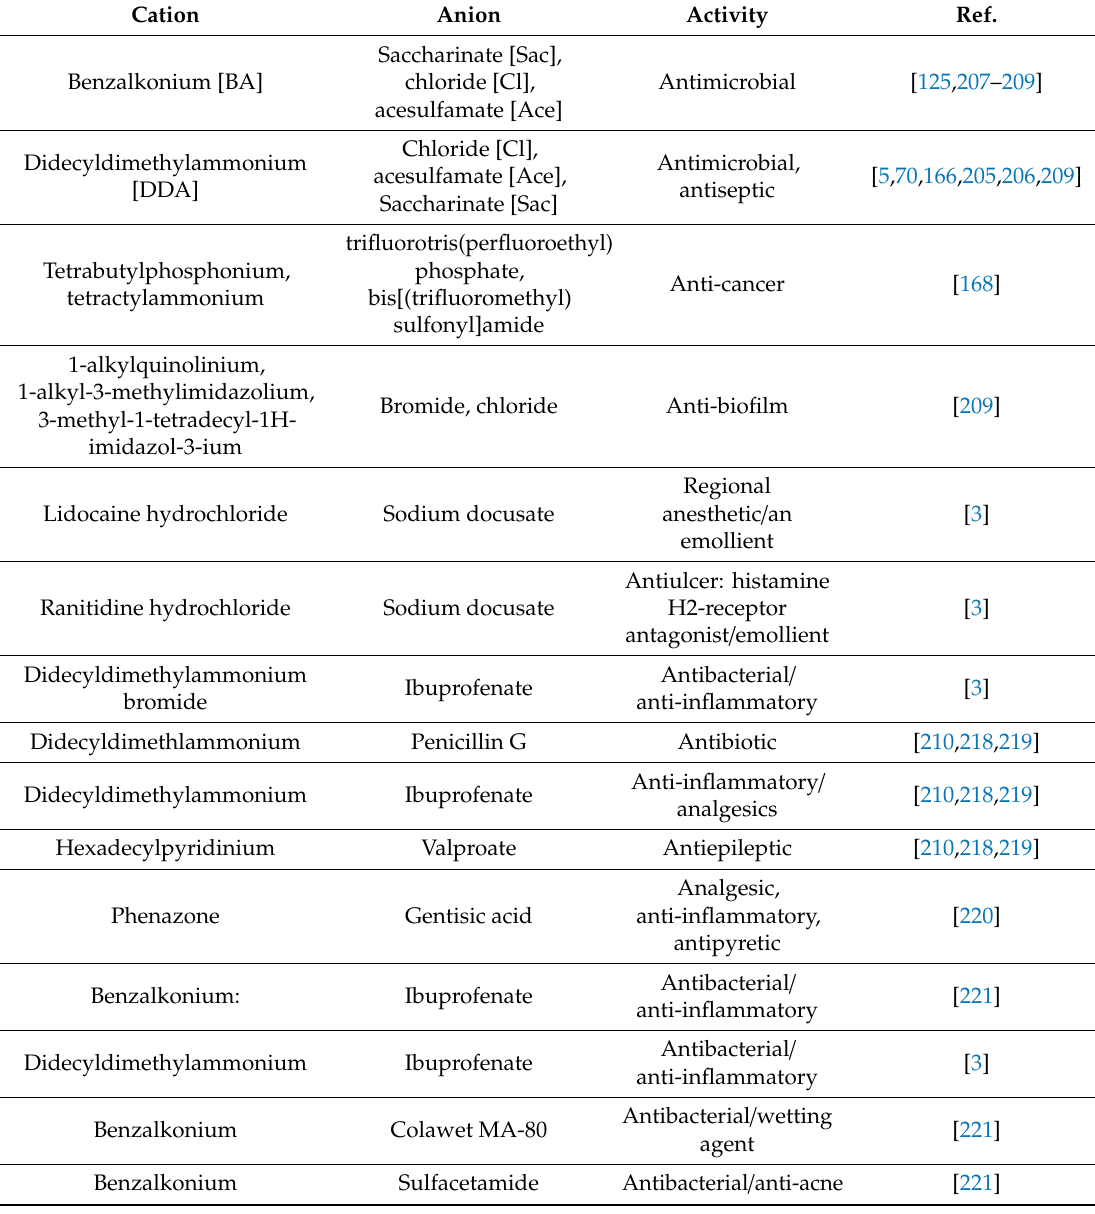
Table 5. Examples of ILs with pharmaceutical